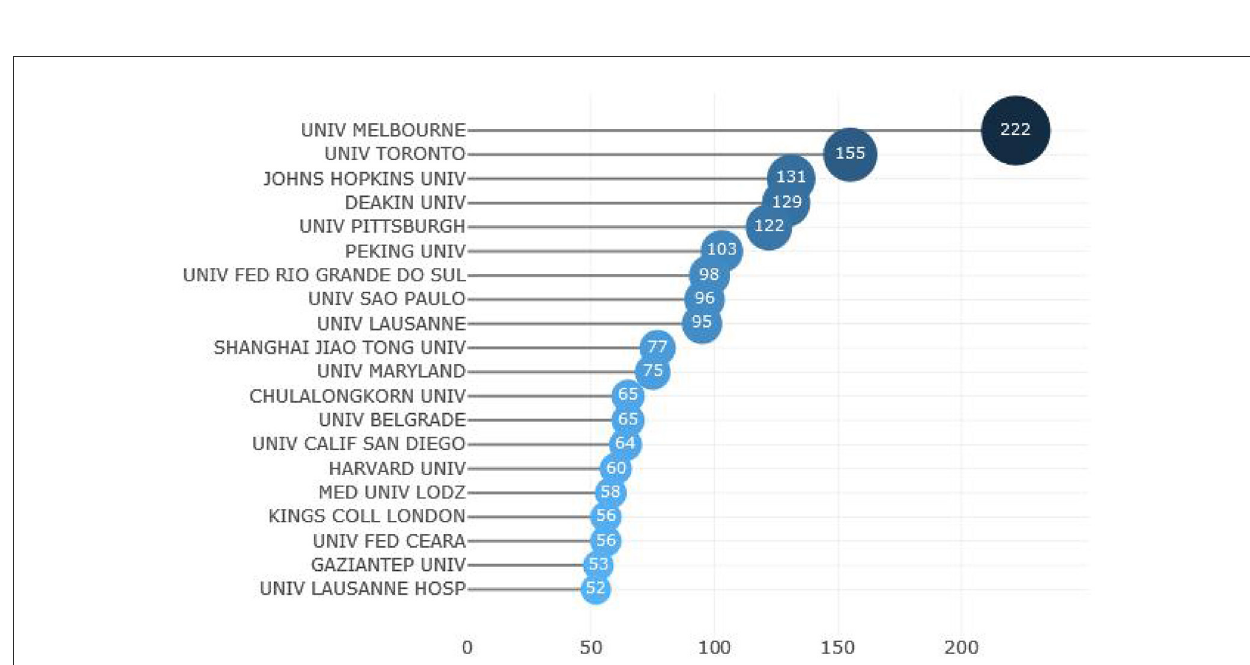
FIGURE3 Top 20 affiliations with most publications in the field of schizophrenia and oxidative